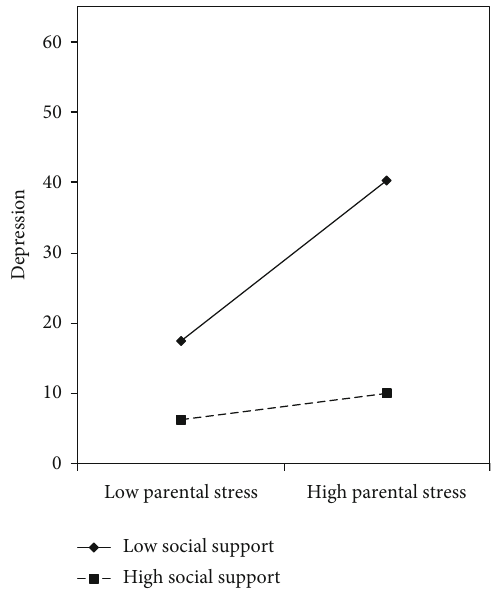
Figure 1: The moderating e ff ect of social